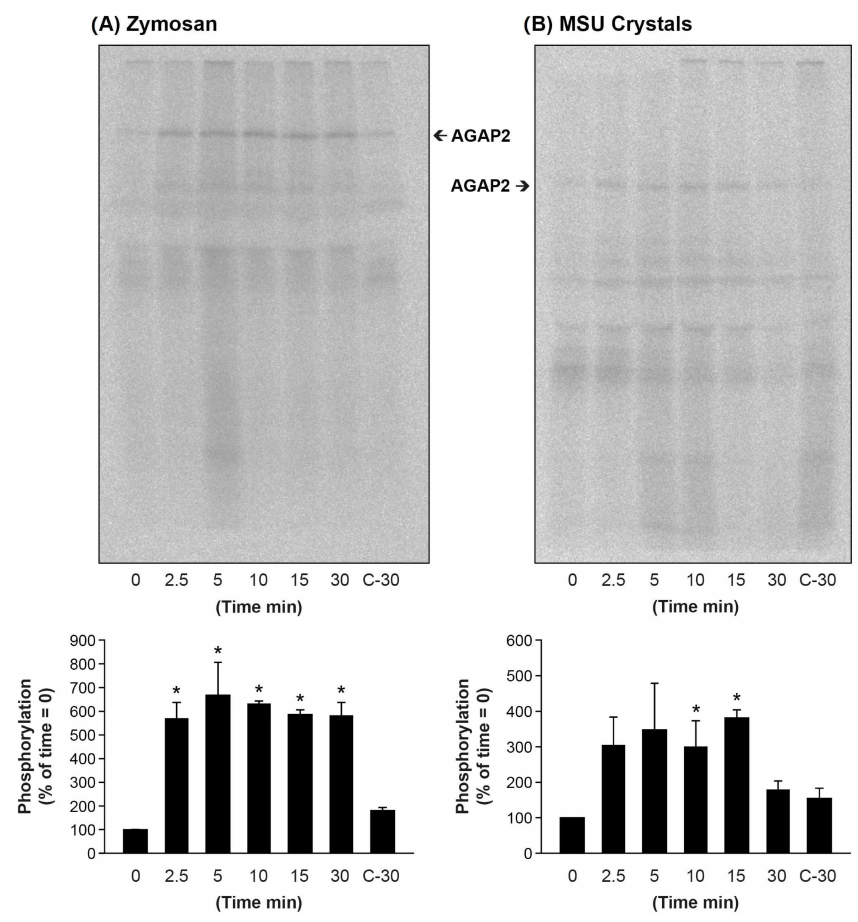
Figure 10. Opsonized zymosan and MSU crystals induce AGAP2 phosphorylation. 32 P-labeled PMMs were stimulated with opsonized zymosan particles in a ratio of 10 particles per cell ( A ) or